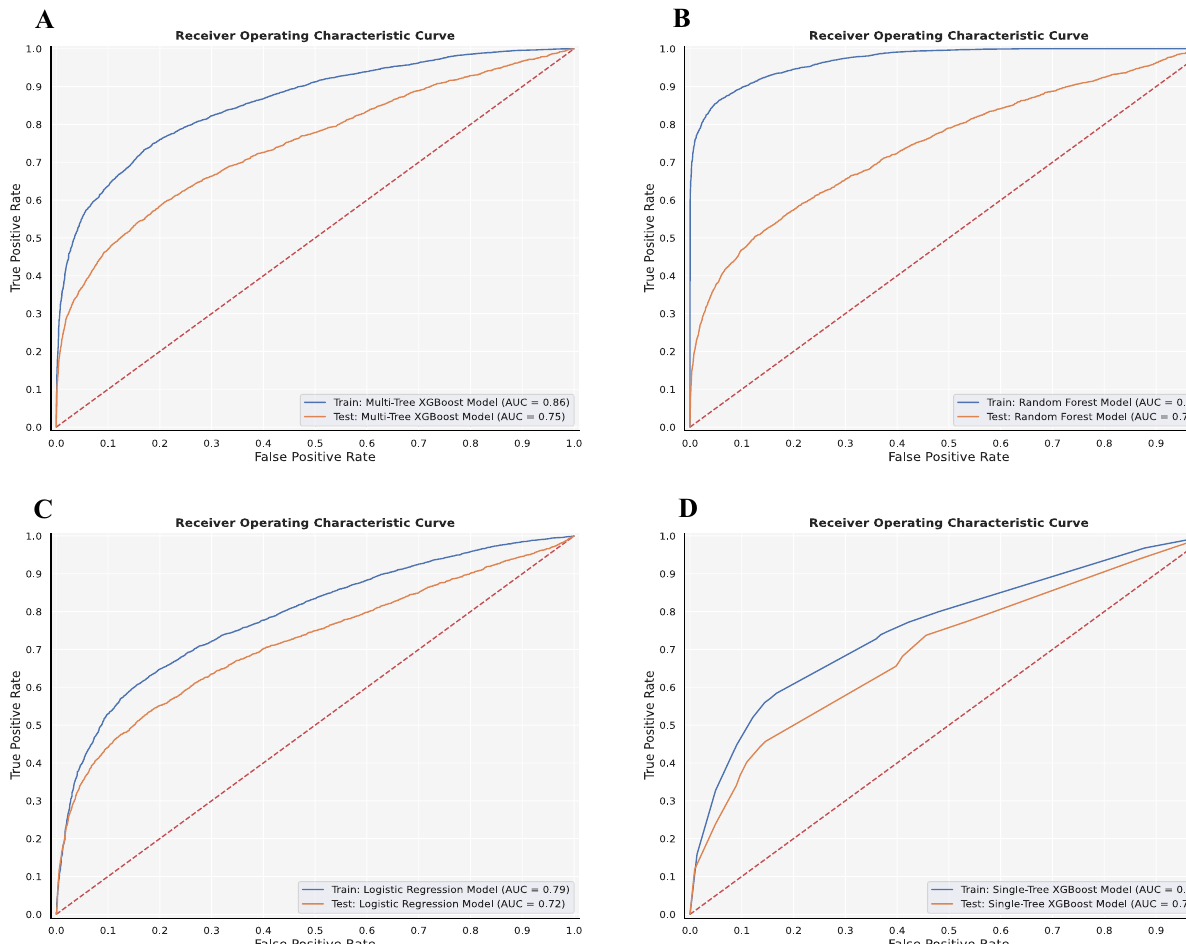
Figure 1. Receiver operating characteristic curves. Receiver operating characteristic curves of ( A ) the multi- tree XGBoost model, ( B ) the random forest model, ( C ) the logistic regression model, and ( D ) the single-tree XGBoost model in their respective train and test